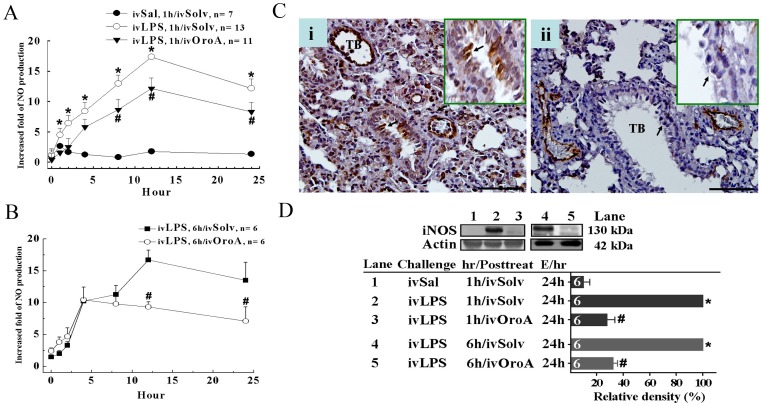
OroA inhibition of LPS-induced plasma NO and expression of iNOS in the lung tissues of the rats.Panel A indicates plasma NO concentrations in control (Sal followed by Solv), LPS (10 mg/kg, iv) followed by Solv-treated, and LPS followed by OroA-treated (15 mg/kg, iv) groups. OroA was administered 1 hr (panel A) or 6 hrs (panel B) and examined 24 hrs (E/24h) after LPS challenge. Data are means±SEM. *P<0.05 indicates significant difference from the normal control. #P<0.05 indicates significantly different from the LPS 1 hr or 6 hrs after LPS challenge. n indicates the number of experiments. In panel Ci, iNOS immunoreactivities (dark brown color) in rat terminal bronchioles (TB) and clara cells (inset of enlarged area indicated by arrows in Fig Ci and ii) were significantly expressed 24 hrs after LPS (10 mg/kg, iv) treatment. The expression was inhibited by OroA (15 mg/kg, iv) administered 6 hrs and examined 24 hrs (E/24h) after LPS challenge (panel Cii). The enhanced iNOS protein production induced by LPS (Lane 2 in panel D) and its inhibition by OroA (15 mg/kg, iv) administered 1 hr (Lane 3 in panel D) or 6 hrs after LPS (lane 5 in panel D). Actin levels were served as internal control. The results are summarized as the relative density (%) of iNOS production. hr/Posttreat (post-treatment hour after LPS treatment); E/hr (examination hour after LPS challenge). Data are means±SEM. *P<0.05 indicates significant difference from the control (Sal followed by Solv, Lane 1 in panel D). #P<0.05 indicates significant difference from the respective LPS alone (ivLPS-ivSolv) group (Lanes 2 and 4 in panel D). Scale bar = 20 µm. The number in each column represents the number of rats examined.